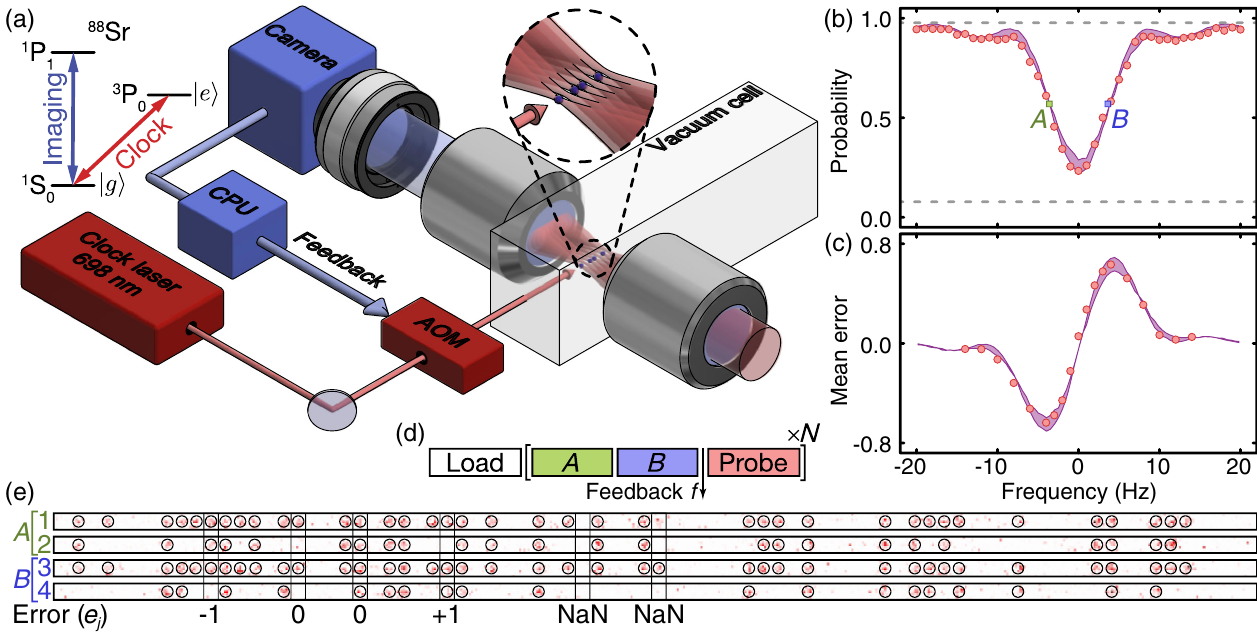
FIG. 1. Atomic array optical clock. (a) We interrogate about 40 88 Sr atoms, trapped in an 81-site tweezer array, on the ultranarrow clock transition at 698 nm and use high-resolution fluorescence imaging at 461 nm to detect population changes in the clock states (labeled j g i and j e i ) with single-atom resolution. This information is processed by a central processing unit (CPU), and a feedback signal is applied to the clock laser frequency using an acousto-optic modulator (AOM). (b) Tweezer-averaged probability to remain in j g i as a function of frequency offset measured with an in-loop probe sequence (circles). Dashed horizontal lines indicate state-resolved detection fidelities (Appendix B 5). To generate an error signal, we interrogate twice: once below ( A ) and once above ( B ) resonance. (c) Tweezer- averaged error signal as a function of frequency offset (circles). The shaded areas in (b) and (c) show results from MC simulations. (d) Simplified experimental sequence, consisting of tweezer loading and N -times-repeated AB feedback blocks followed by an optional probe block, with N ¼ 10 throughout. (e) To detect the clock state population in block A , we take a first image before interrogation to identify which tweezers are occupied and a second image after interrogation to detect which atoms remain in j g i (images 1 and 2). The same procedure is repeated for block B (images 3 and 4). We show fluorescence images with identified atoms (circles) (Appendix B 4) and examples of single tweezer error signals e j